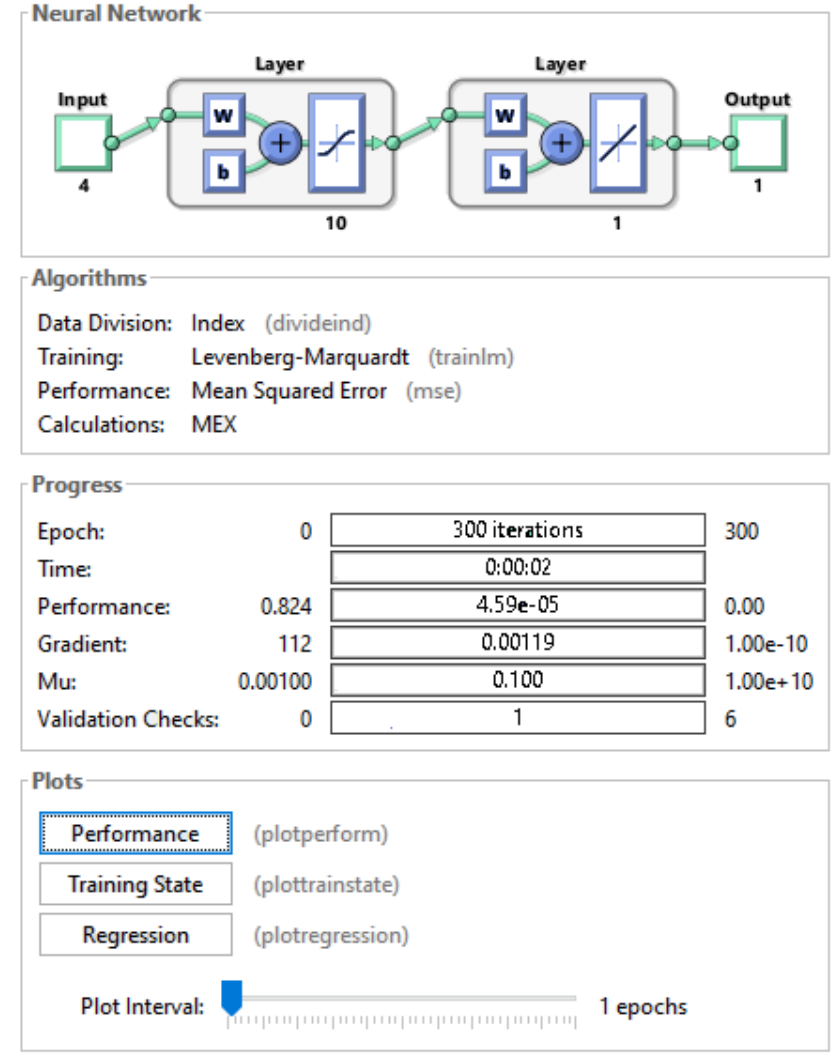
Figure 32. The training dataset of the motion process input and output.